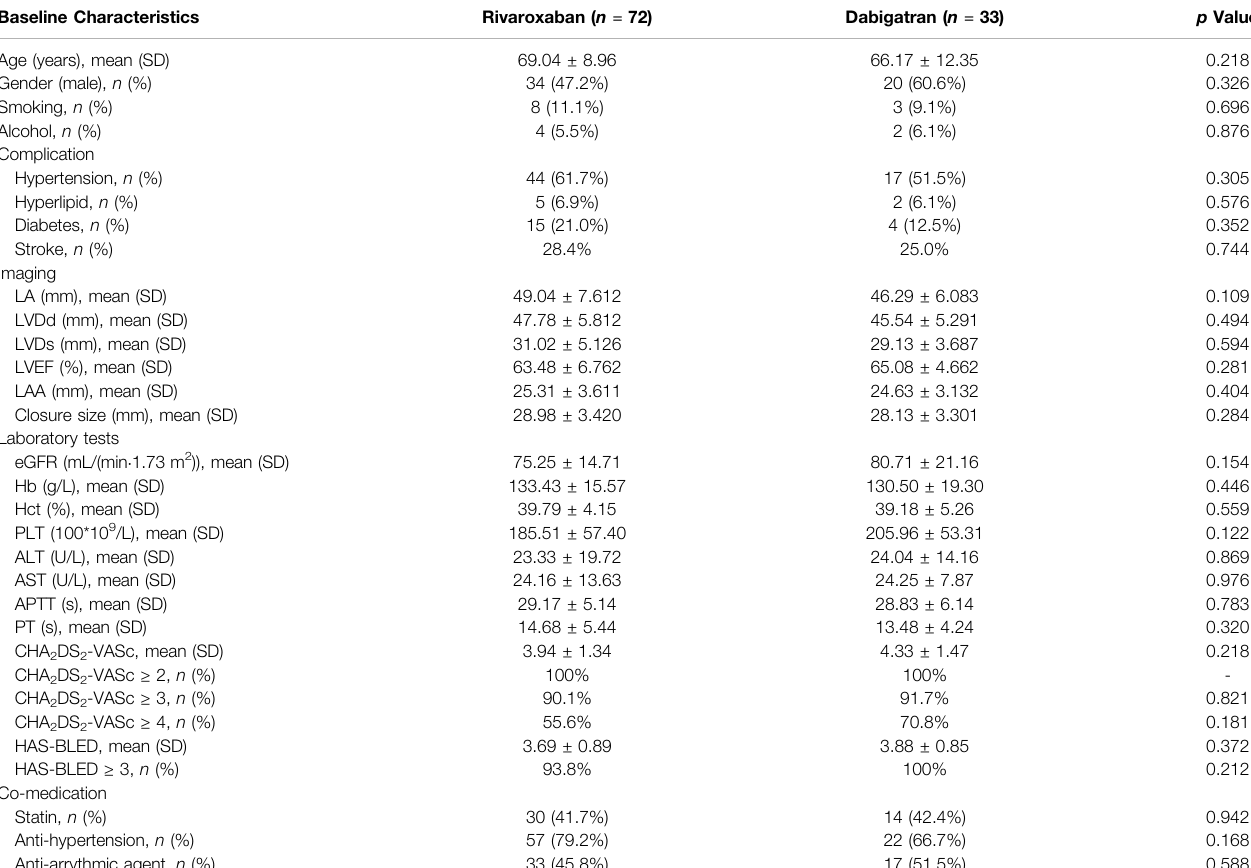
TABLE 1 | Baseline characteristics of the study population. Baseline Characteristics